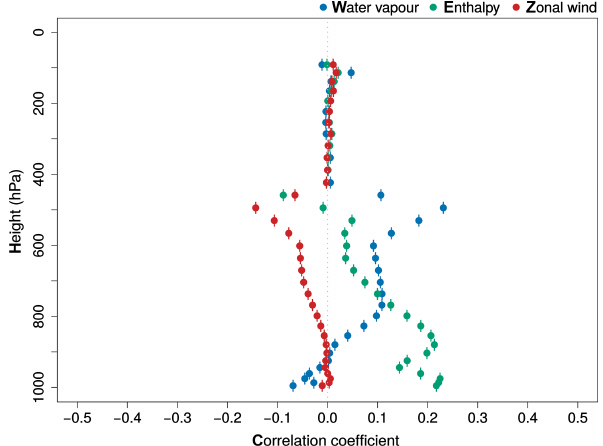
Figure 8. The Pearson correlation coefficients of the transport flux error with respect to the total transport flux of water vapour (blue), enthalpy (green) and zonal wind (red) at all model levels. The error bars show the 95% confidence